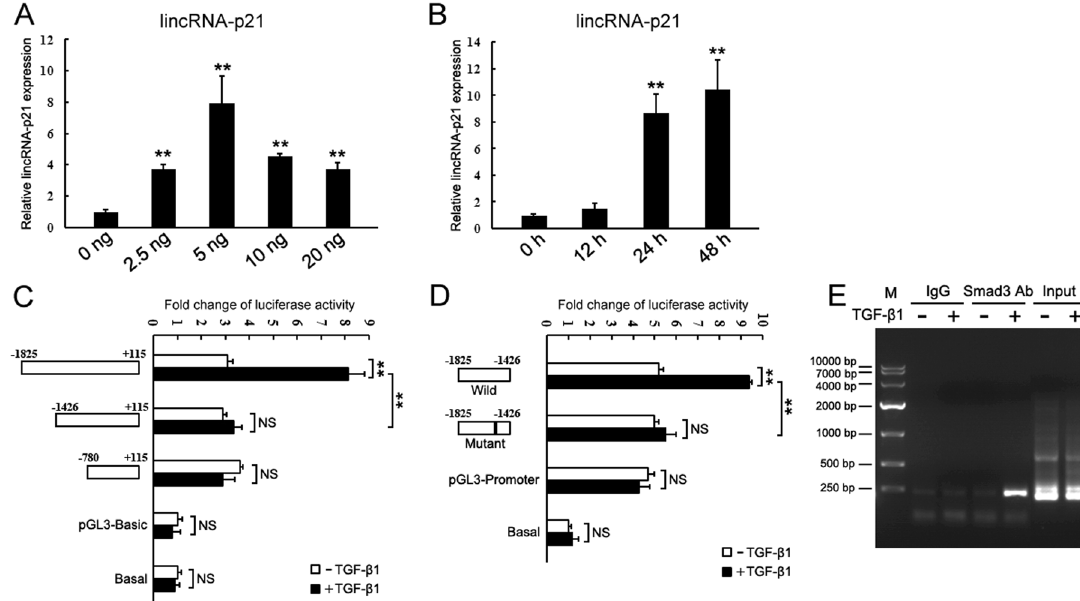
Figure 6. LincRNA-p21 is induced by TGF- β . ( A ) The expression of lincRNA-p21 in AML12 cell treated by TGF- β 1 at indicated concentrations for 24 h. ( B ) The expression of lincRNA-p21 in AML12 cell treated by TGF- β 1 at a final concentration of 5 ng/ μ l for indicated times. ( C and D ) Schematic representation of lincRNA-p21 promoter reporter constructs using pGL3-Basic ( C ) or pGL3-Promoter ( D ) and analysis of their reporter activities after treatment with TGF- β 1 for 24 h. The results are shown as fold change compared with cells without plasmid transfection. ( E ) ChIP assays for Smad3 were performed with chromatin from AML12 cells treated with TGF- β 1 for 24 h. Precipitated DNA was amplified with oligonucleotides spanning regions of predicted Smad3 binding site. Total inputs are indicated. Data are the mean + SEM of three independent experiments. ** P < 0.01. NS, no significant